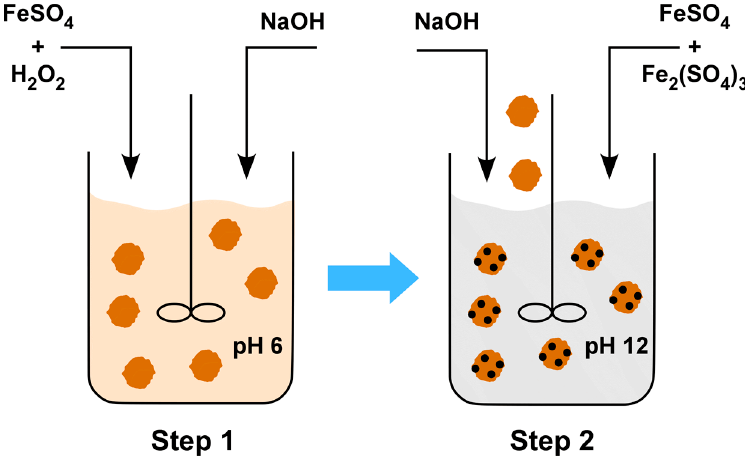
Figure 1. Schematic representation of Fe 3 O 4 /FeOOH nanocomposites synthesis steps.